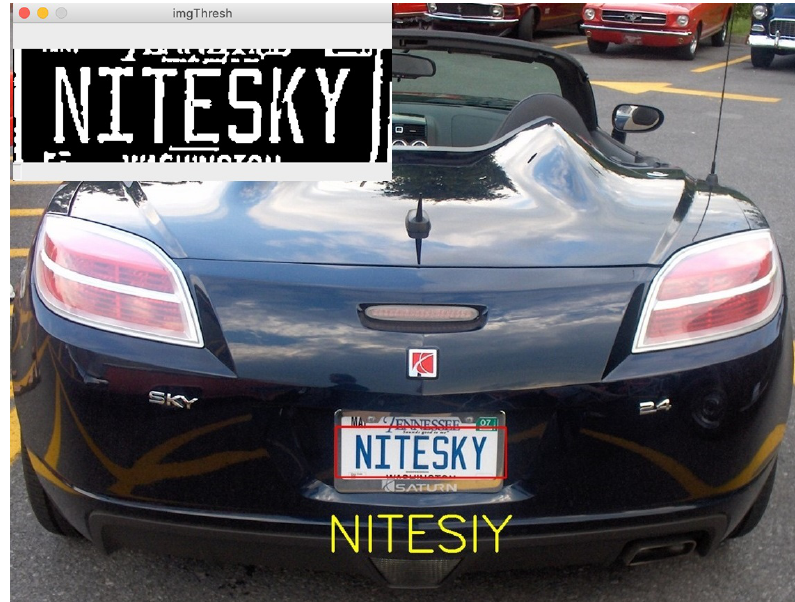
Figure 8. An example of a character mismatch error.